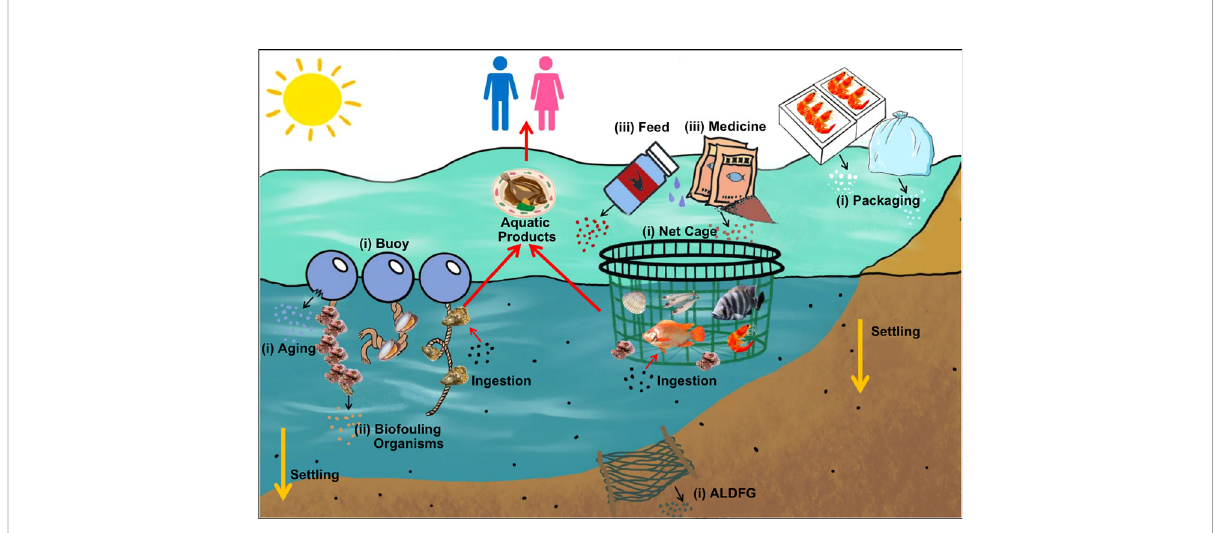
FIGURE 1 Schematic diagram of the sources and migration of